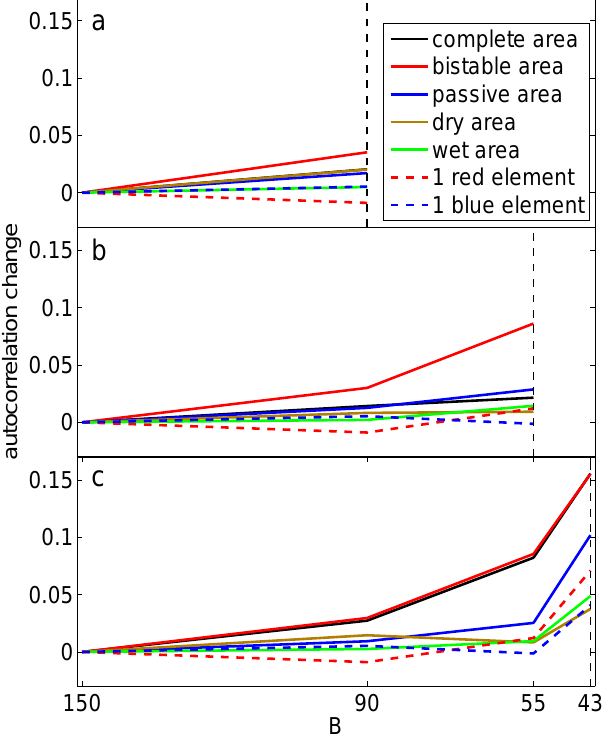
Fig. 9. Autocorrelation changes of projections on leading EOFs for system 3 with multiplicative noise. The leading EOFs have been calculated for (a) B 2 = 90, (b) B 3 = 55, (c) B 4 = 43. In each case, all previous time series (including the one used for the EOF) are projected on the according EOF. The analysis is applied to the full system (black) as well as only parts of the system (other colours). The colours correspond to the elements in Fig. 4. Parameter settings correspond to set 21 in Table 4.